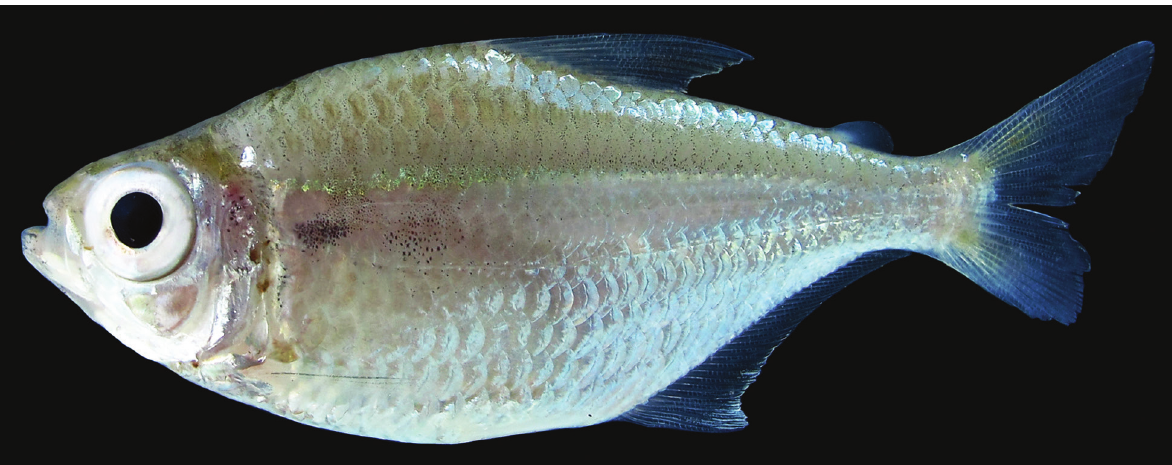
Figure 4. Moenkhausia megalops , GEA 2127, 61.4 mm SL, live specimen, Brazil, Pará State, rio Aurá, tributary of rio Guamá basin, Utinga State Park, Água Preta lake. Photo by M.